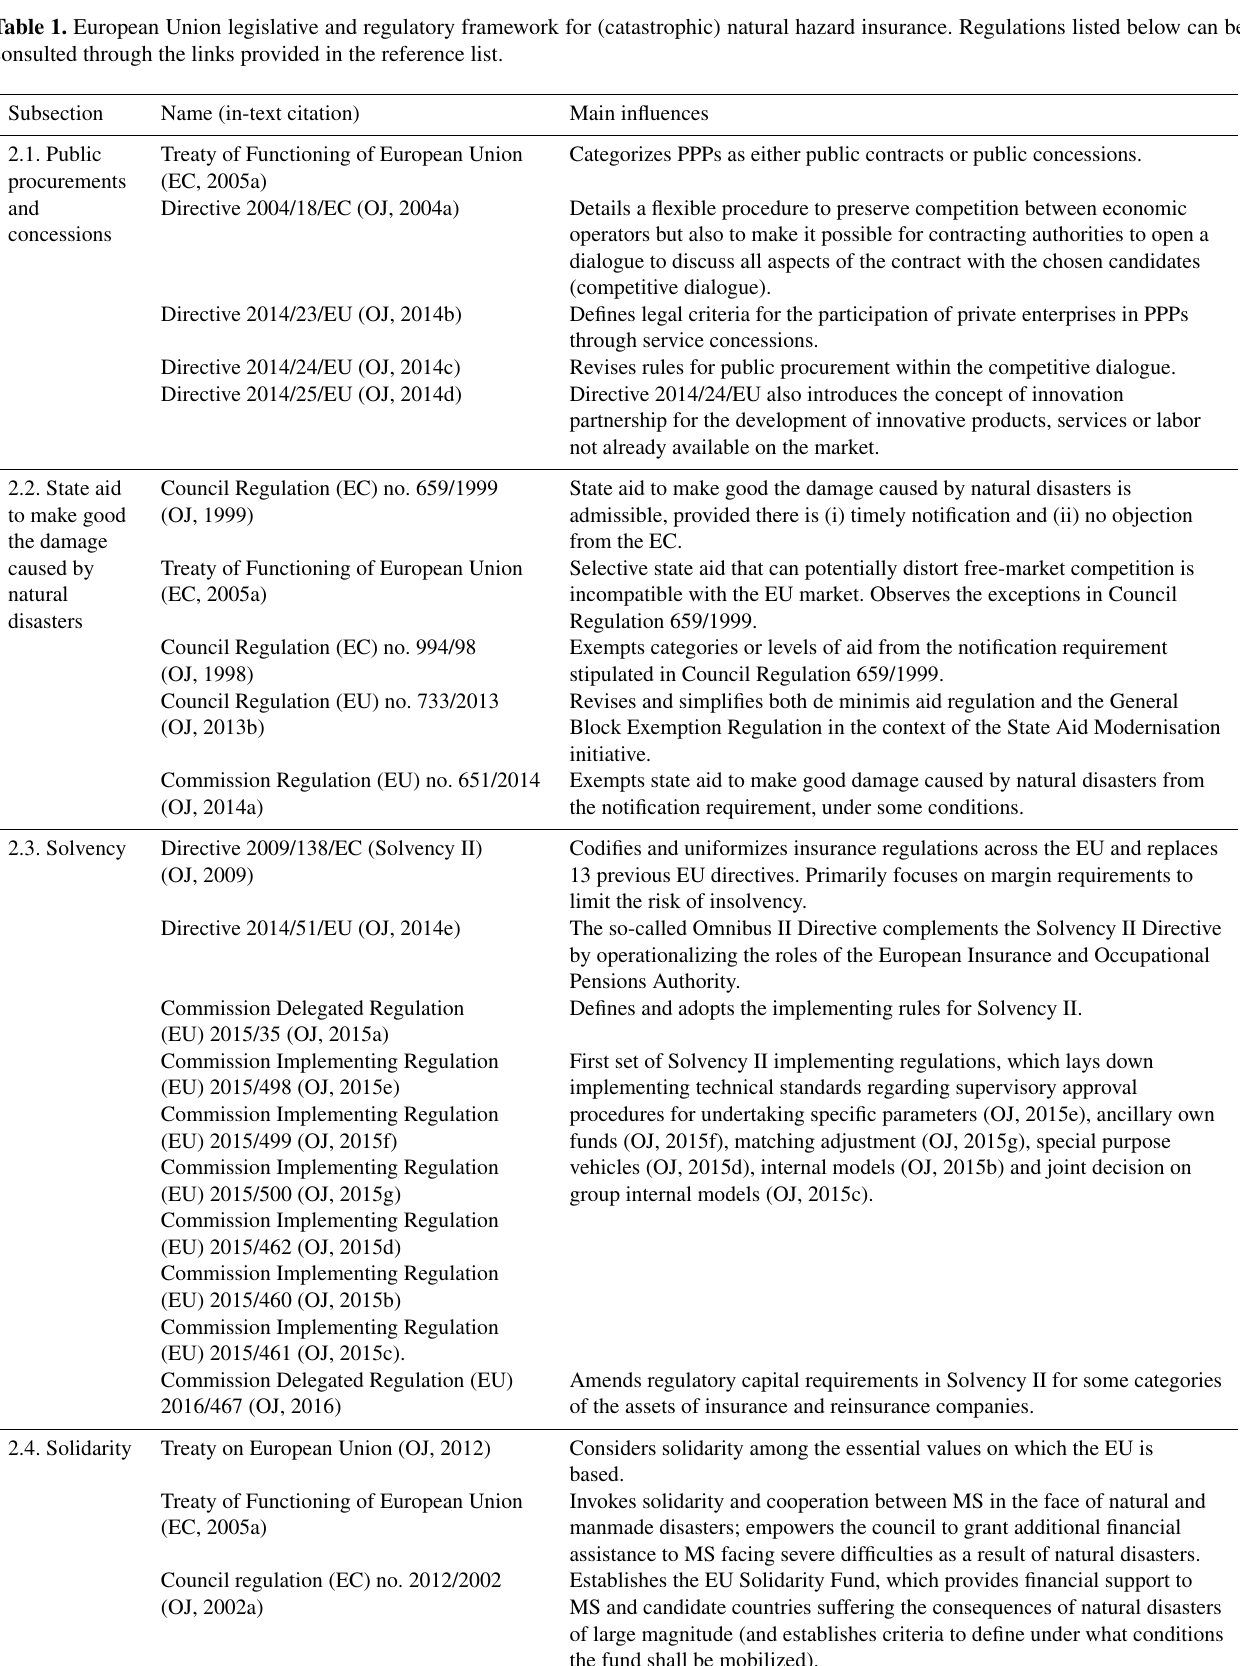
Table 1. European Union legislative and regulatory framework for (catastrophic) natural hazard insurance. Regulations listed below can be consulted through the links provided in the reference